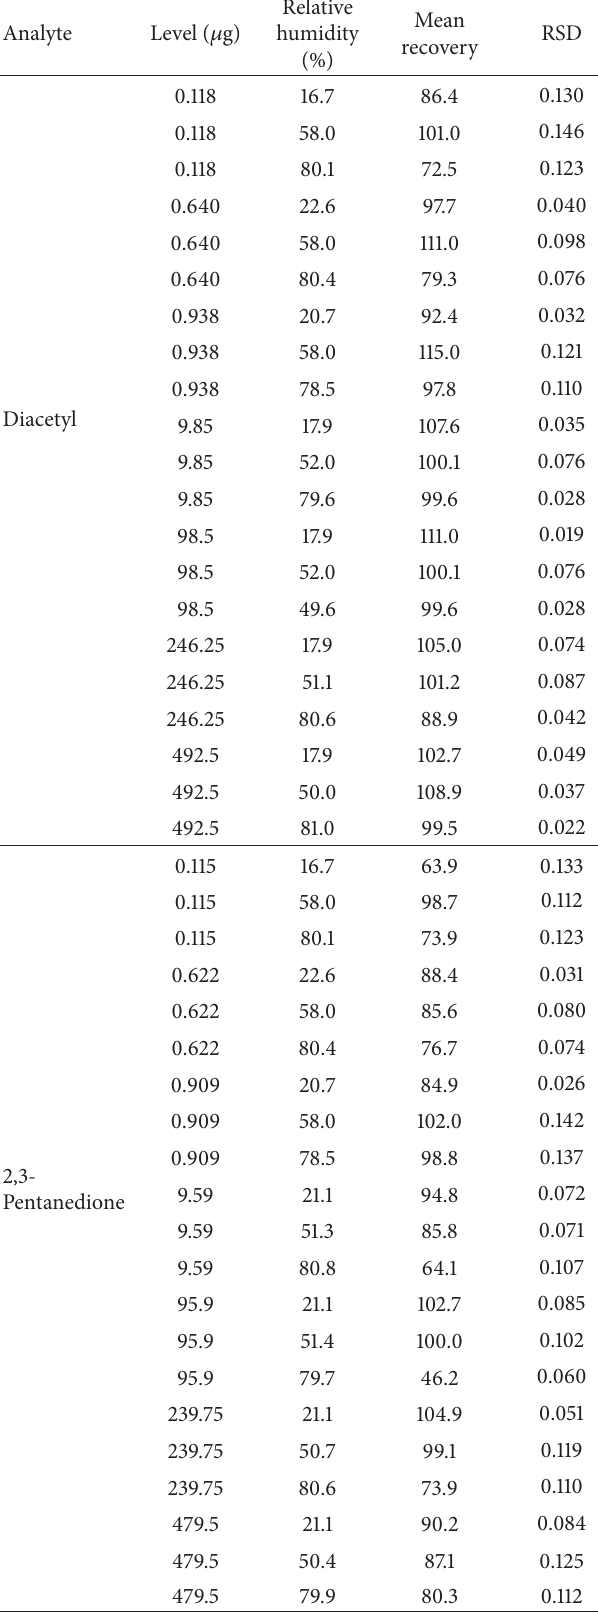
Table 6: Low level recovery study for diacetyl, 2,3-pentanedione, 2,3-hexanedione, and 2,3-heptanedione.